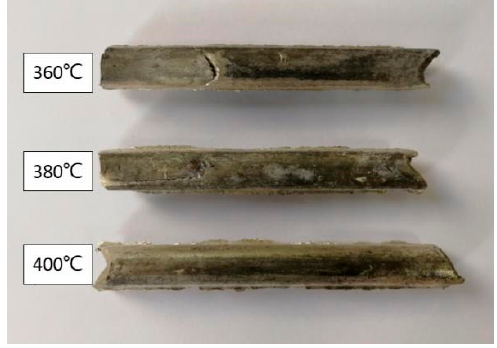
Figure 3. Photograph of rolled samples.